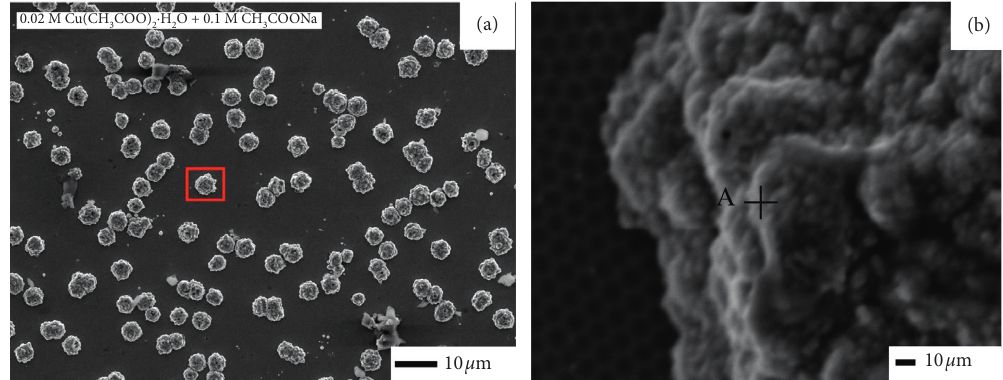
Figure 7: SEM images of electrodeposition of the CuO-Cu